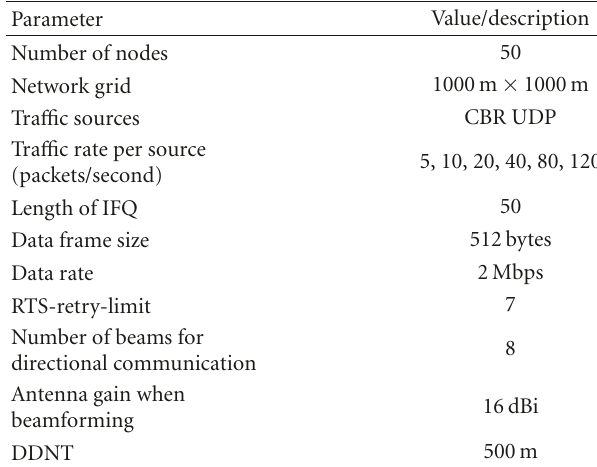
Table 3: Simulation parameters.